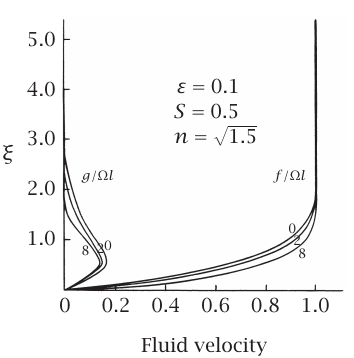
Figure 3.4 . Variations of f/ Ω l and g/ Ω l for different values of A , the mag- nitude of fluctuations in suction velocity.